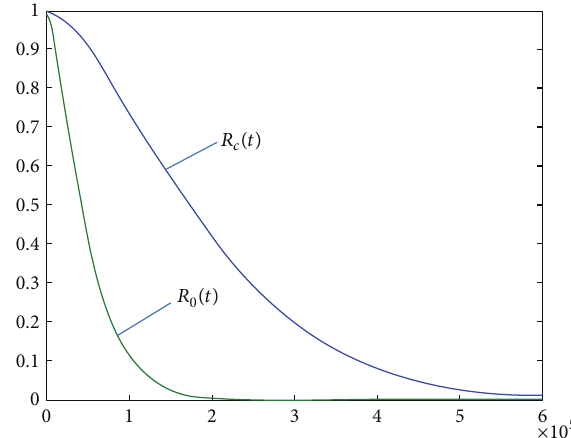
Figure 8: Curve graph comparing the reliability distribution of bogie subsystem based on dependent and independent components.